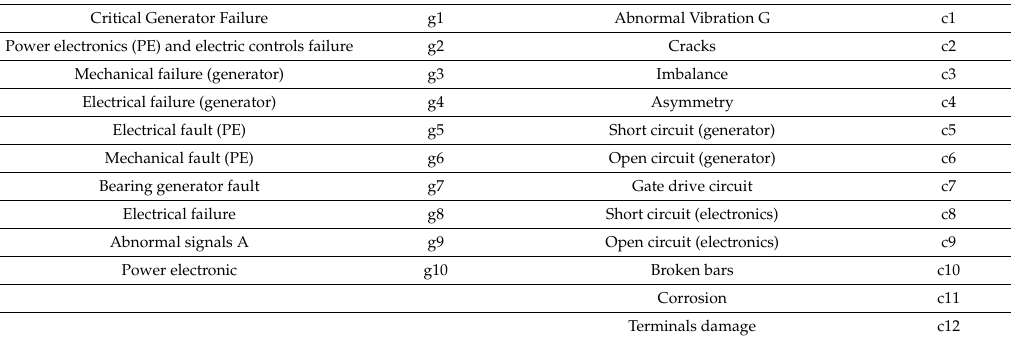
Table 1. Main faults in the converter, electrical and electronic components and generator, based on [37]. c1–c2 and g1–g10 are the nodes of the fault tree (FT) in Figure